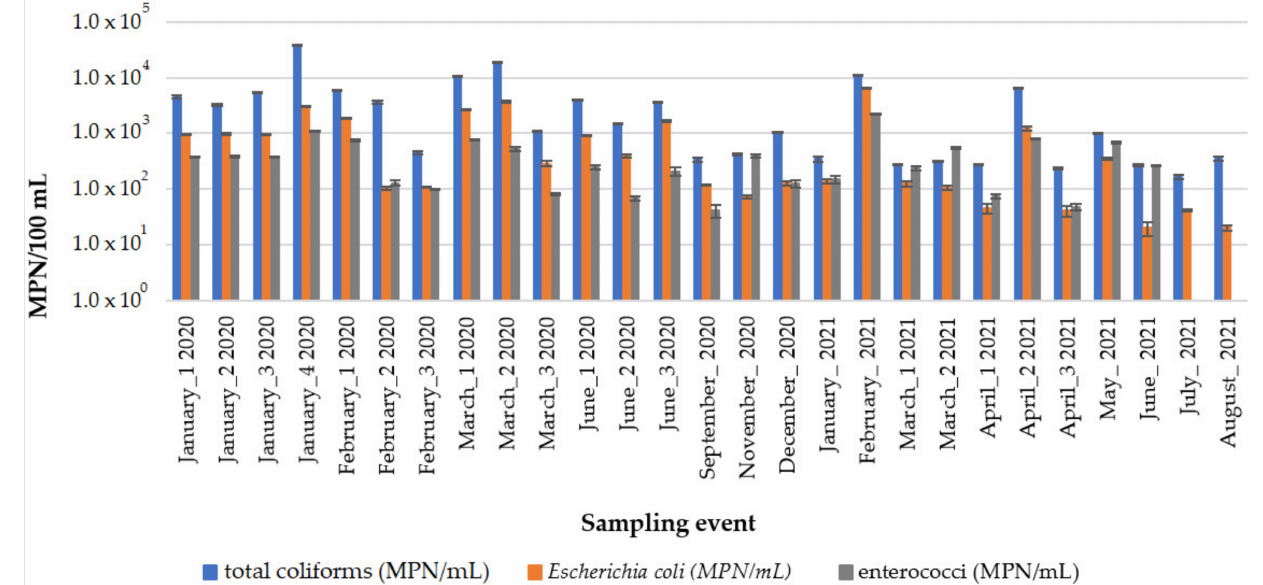
Figure 1. Occurrence levels (MPN/100 mL) of water quality indicator bacteria (total coliforms, E. coli , and enterococci) in river